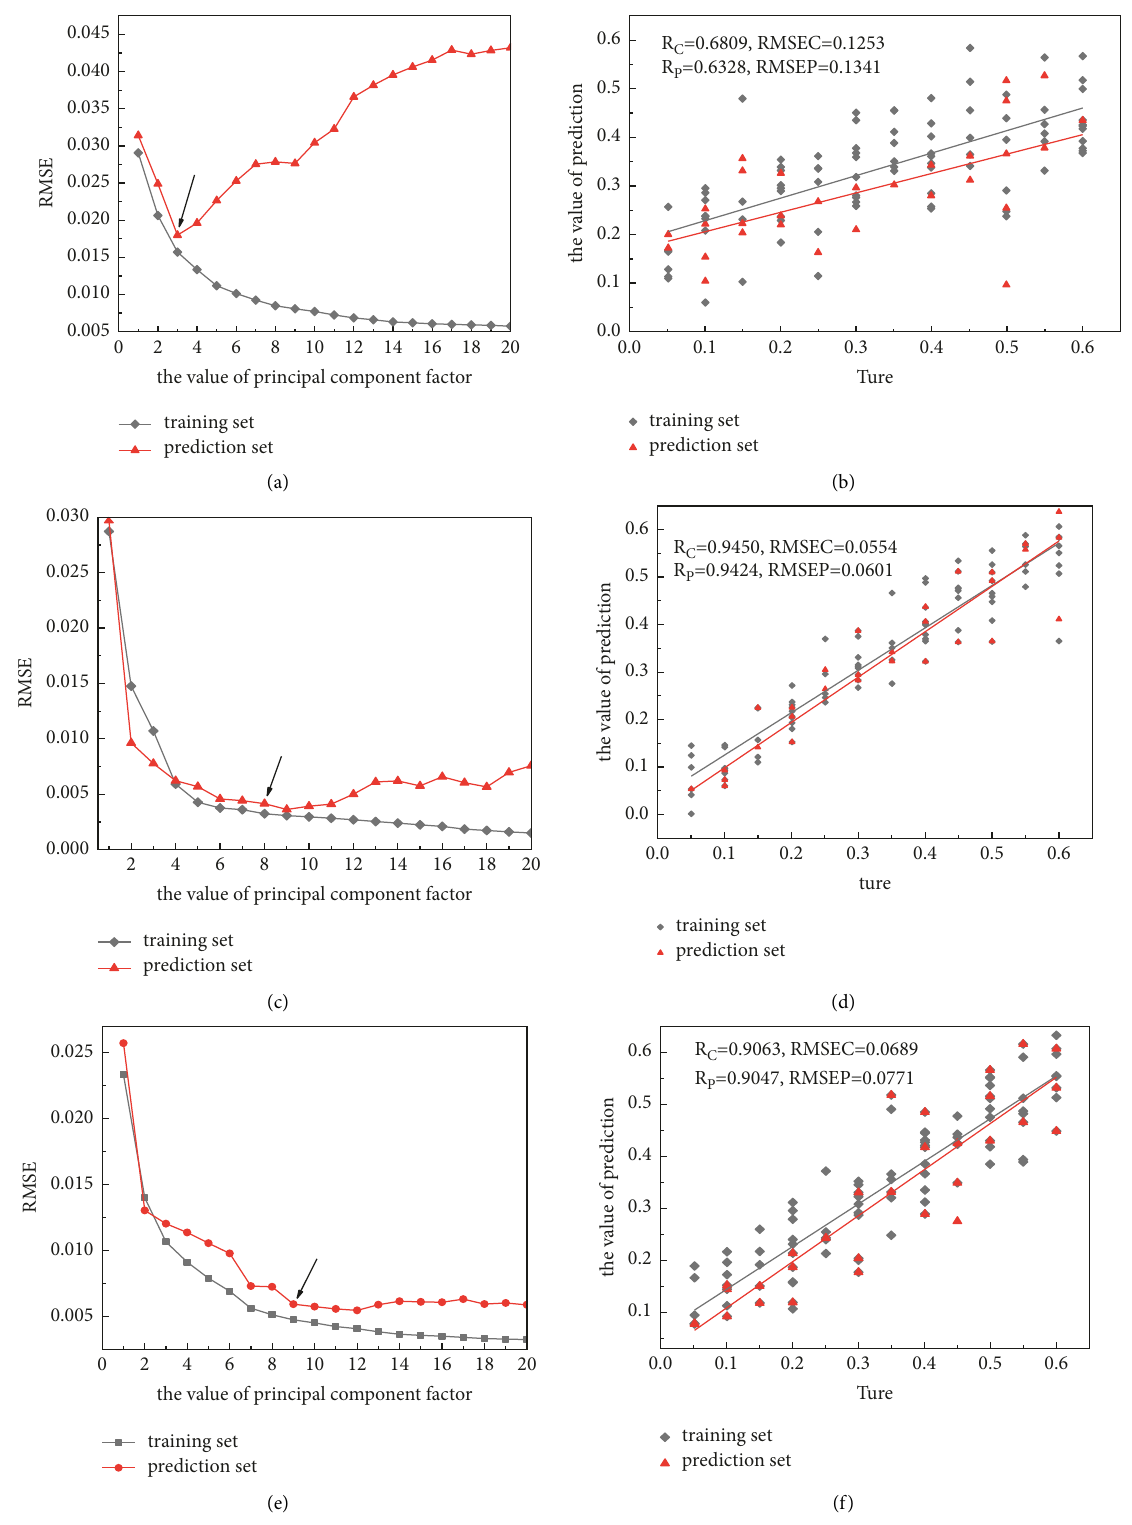
Figure 9: Results of the PLS model of Panax notoginseng powder adulteration; (a) is the diagram of principal component factor; (b) is scatter diagram of adulterating with zedoary turmeric powder; (c) is the diagram of principal component factor; (d) is scatter diagram of adulterating with rice flour; (e) is the diagram of principal component factor; (f) is scatter diagram of adulterating with wheat